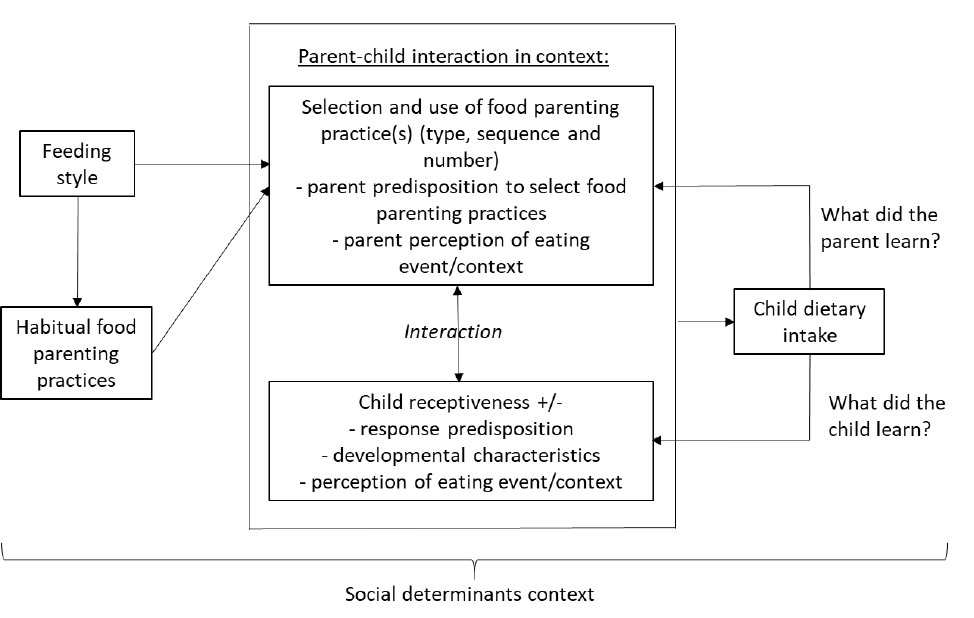
Figure 1. Model for precision food parenting practices interventions.